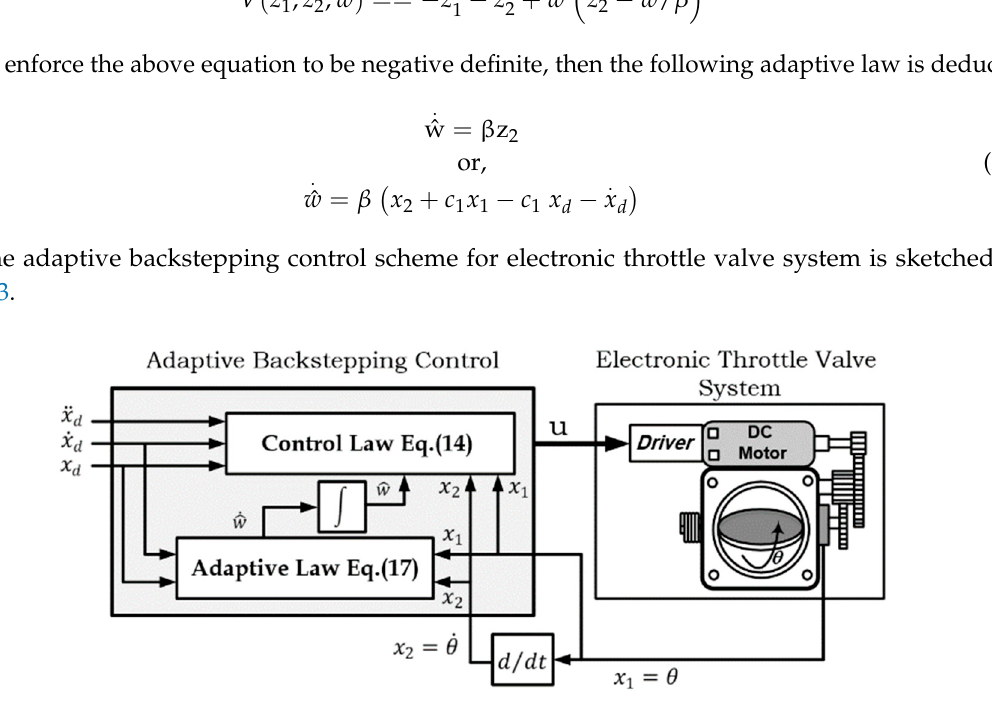
Figure 3. The schematic diagram of ETV system controlled by adaptive backstepping controller.